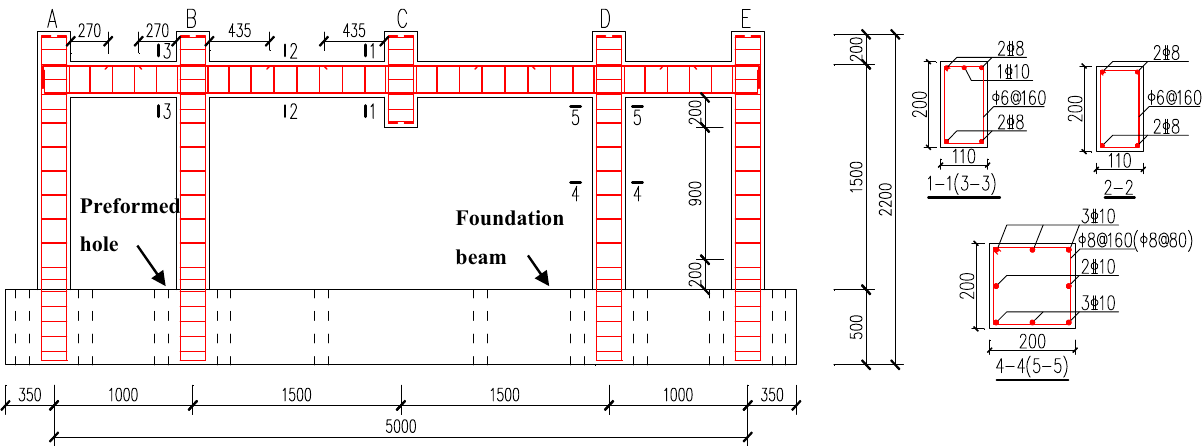
Figure 2: Concrete dimensions and steel reinforcements of S1 and